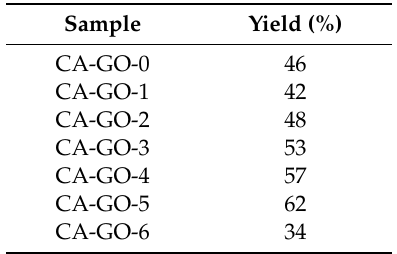
Table 1. Yields (%) of the generated CA-GO